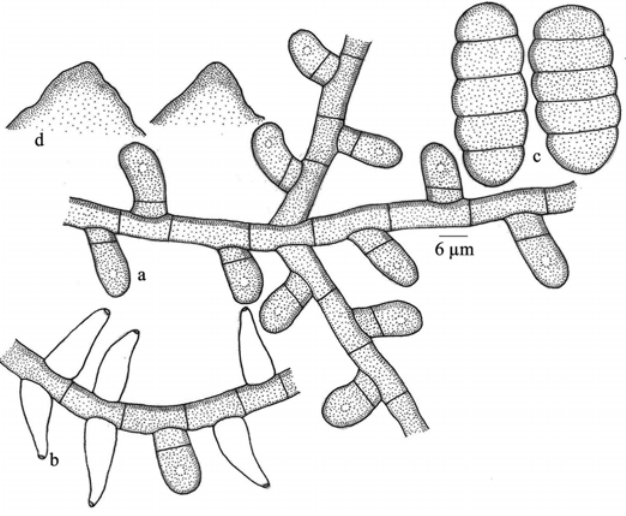
Figure 1. Asperidiella ficicola sp. nov. a - Appressorium; b - Phialide; c - Ascospores; d - Perithecial